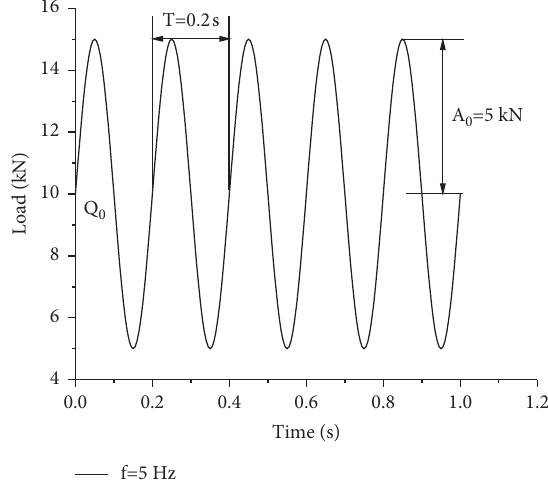
Figure 4: Dynamic loading wave ( f �